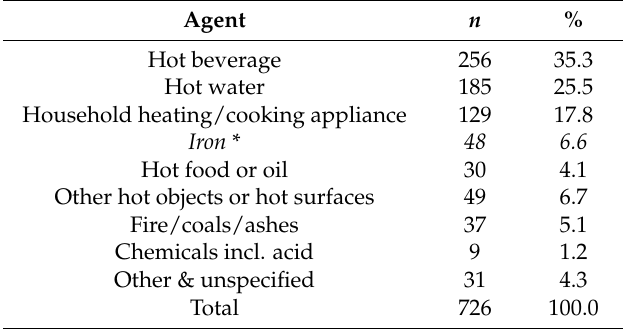
Table 4. Agents causing burn or scald injuries in children aged one year admitted to